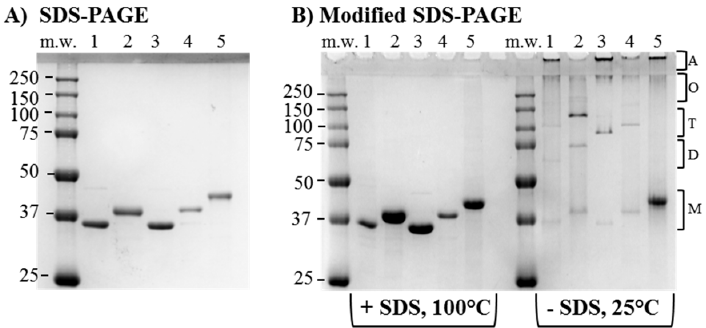
Figure 3. Electrophoretic analysis of purified PorB/VDs. Coomassie staining of ( A ) Conventional SDS-